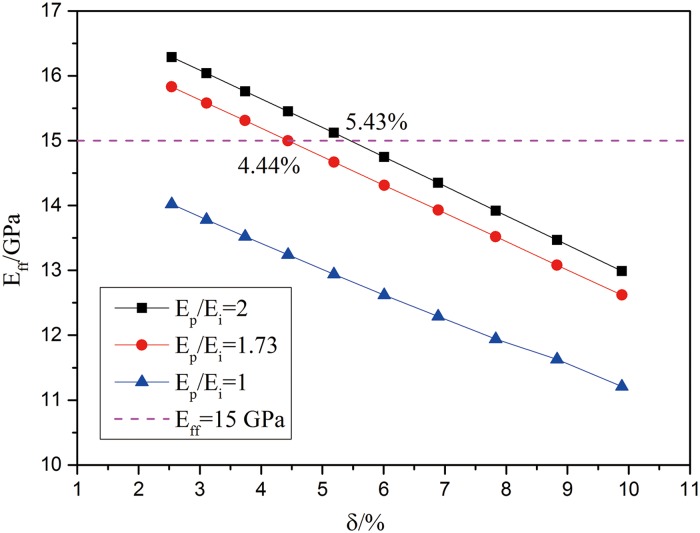
The relationship between Eff, porosity and Ep/Ei when the RPTD is kept the same.